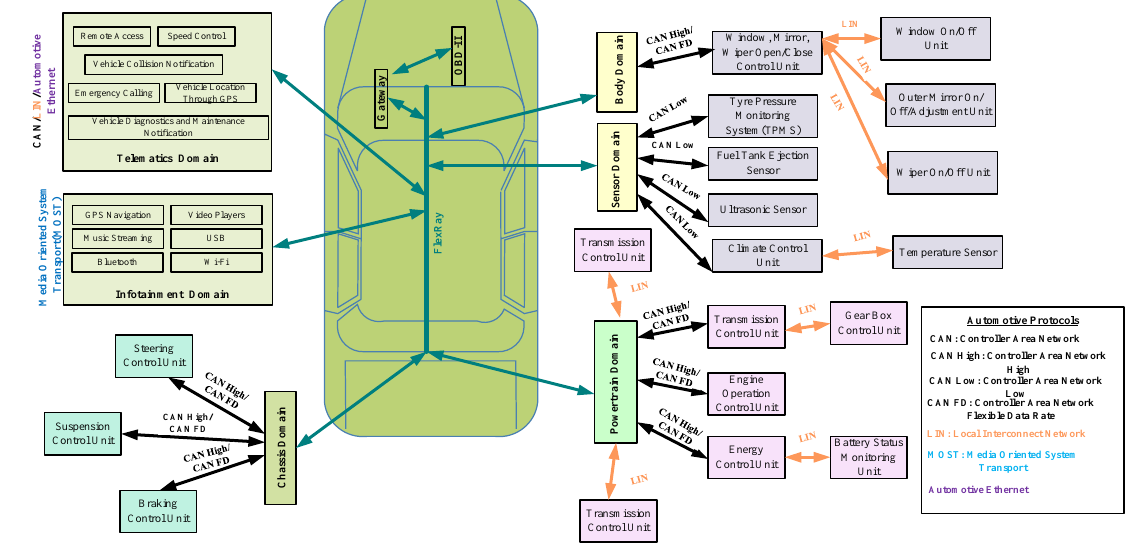
Figure 3. In-Vehicle Network Architecture with Automotive Protocols.